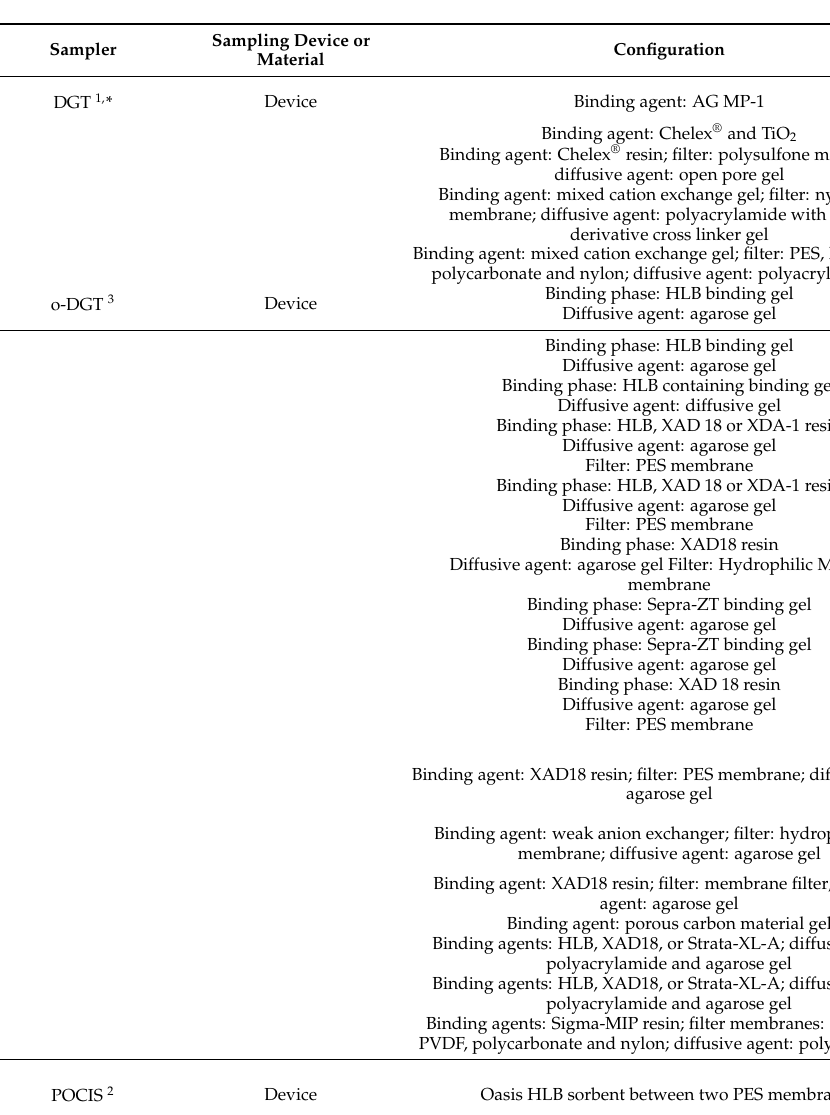
Table 2. Different types of passive samplers being used in wastewater surveillance and their